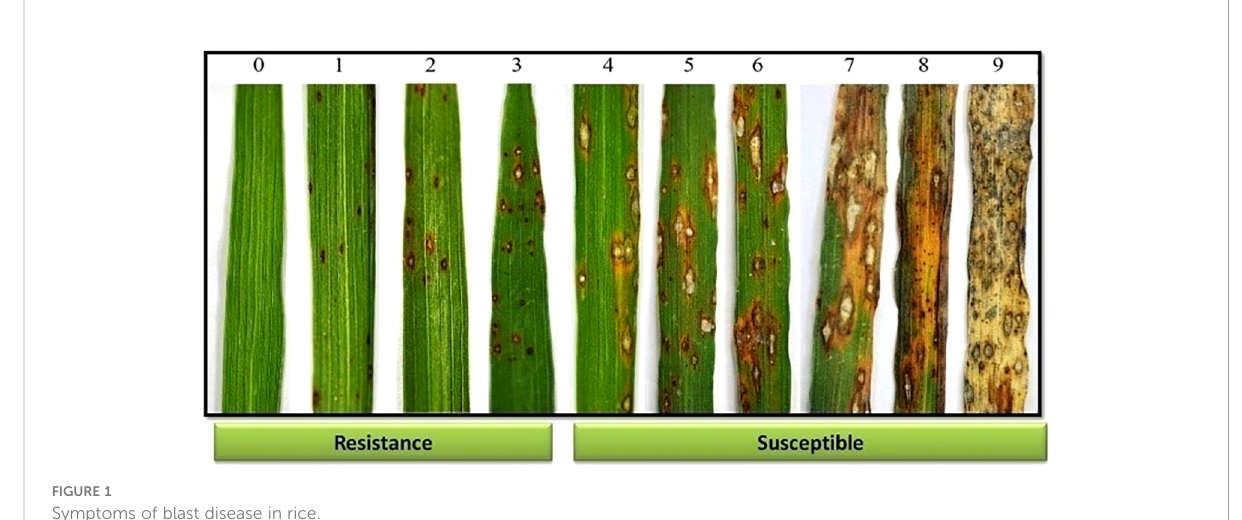
FIGURE 1 Symptoms of blast disease in rice.